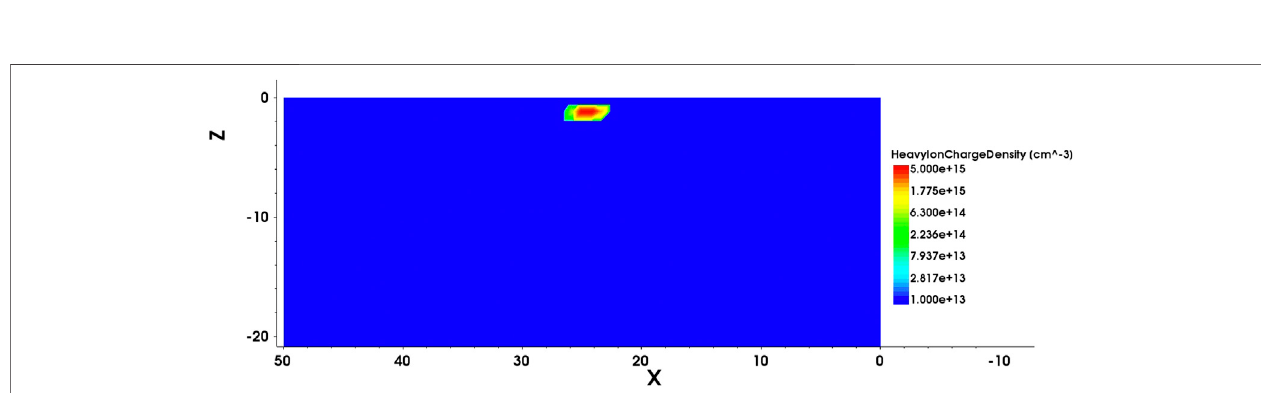
Frontiers in Physics |